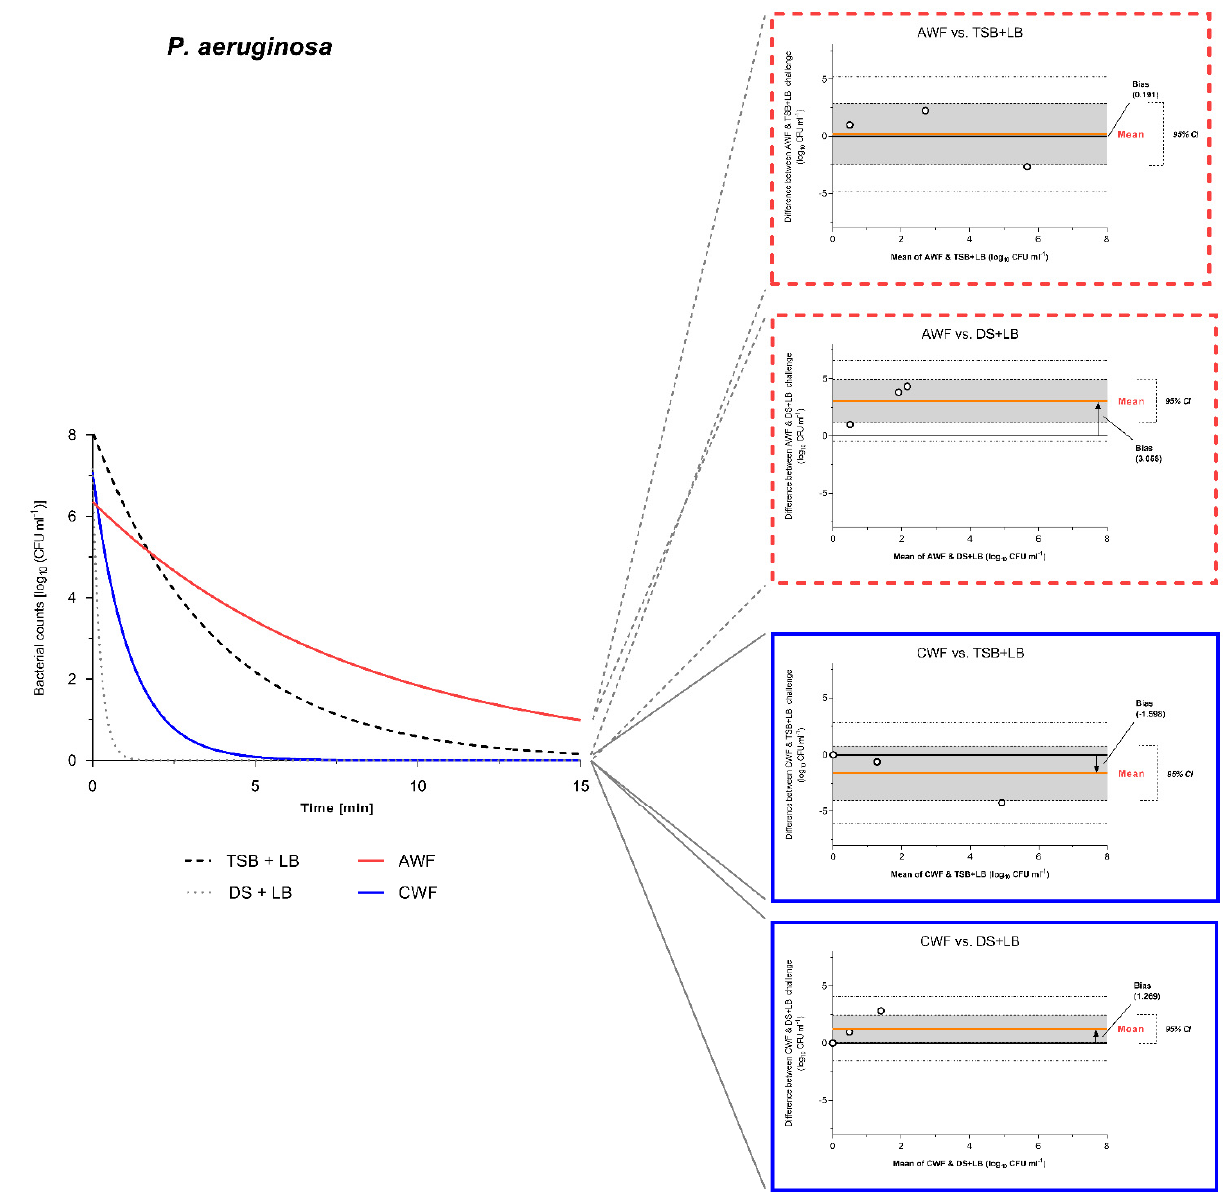
Figure 7. Bland-Altman (B&A) plot comparing bacterial reduction results against P. aeruginosa under AWF challenge to TSB + LB and DS + LB. Best fitted curves of the reduction in bacterial counts over the course of 15 min exposure time for AWF (red line), CWF (blue line), DS + LB (dotted line), and TSB + LB (dashed line) are depicted on the left. Bland-Altman plots for the comparison between different challenge methods are shown on the right (dashed red frame for comparisons against AWF; blue solid line against CWF). Red line labeled “mean” marks the mean bias between the compared methods and deviation from the line of equality (y = 0). Grey area around the mean marks the 95% confidence interval. If the line of equality (y = 0) is enclosed in the 95% CI, no significant difference between methods can be postulated, if the line is excluded from the 95% CI, the methods provide significantly different results. The bias is stated numerically in the form of units measured (here log 10 CFU/mL).